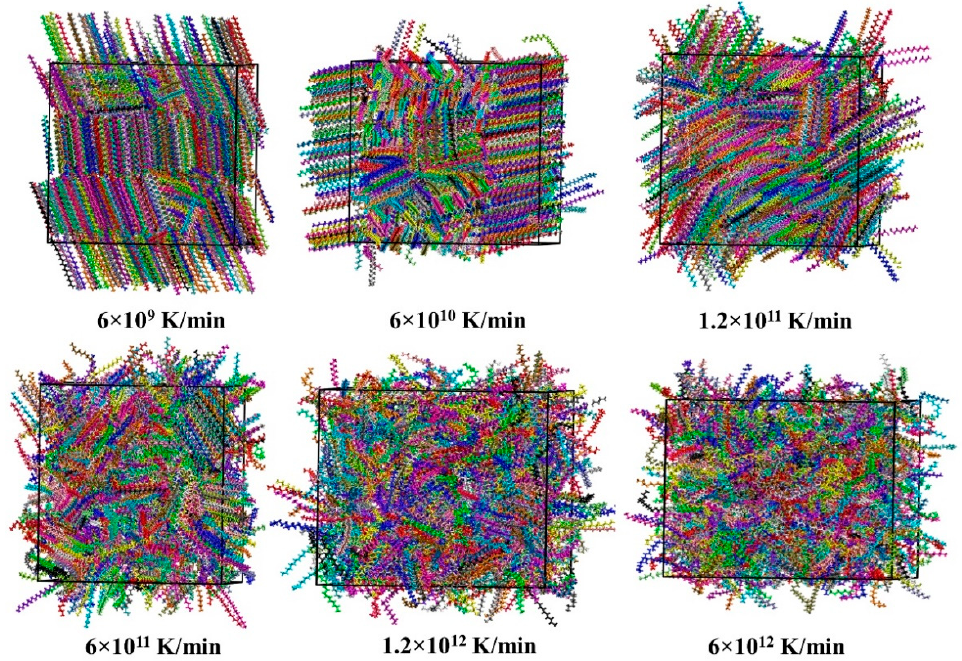
Figure 5. Snapshots of a simulation box with n ‐ eicosane molecules at T = 250 K for different cooling rates.